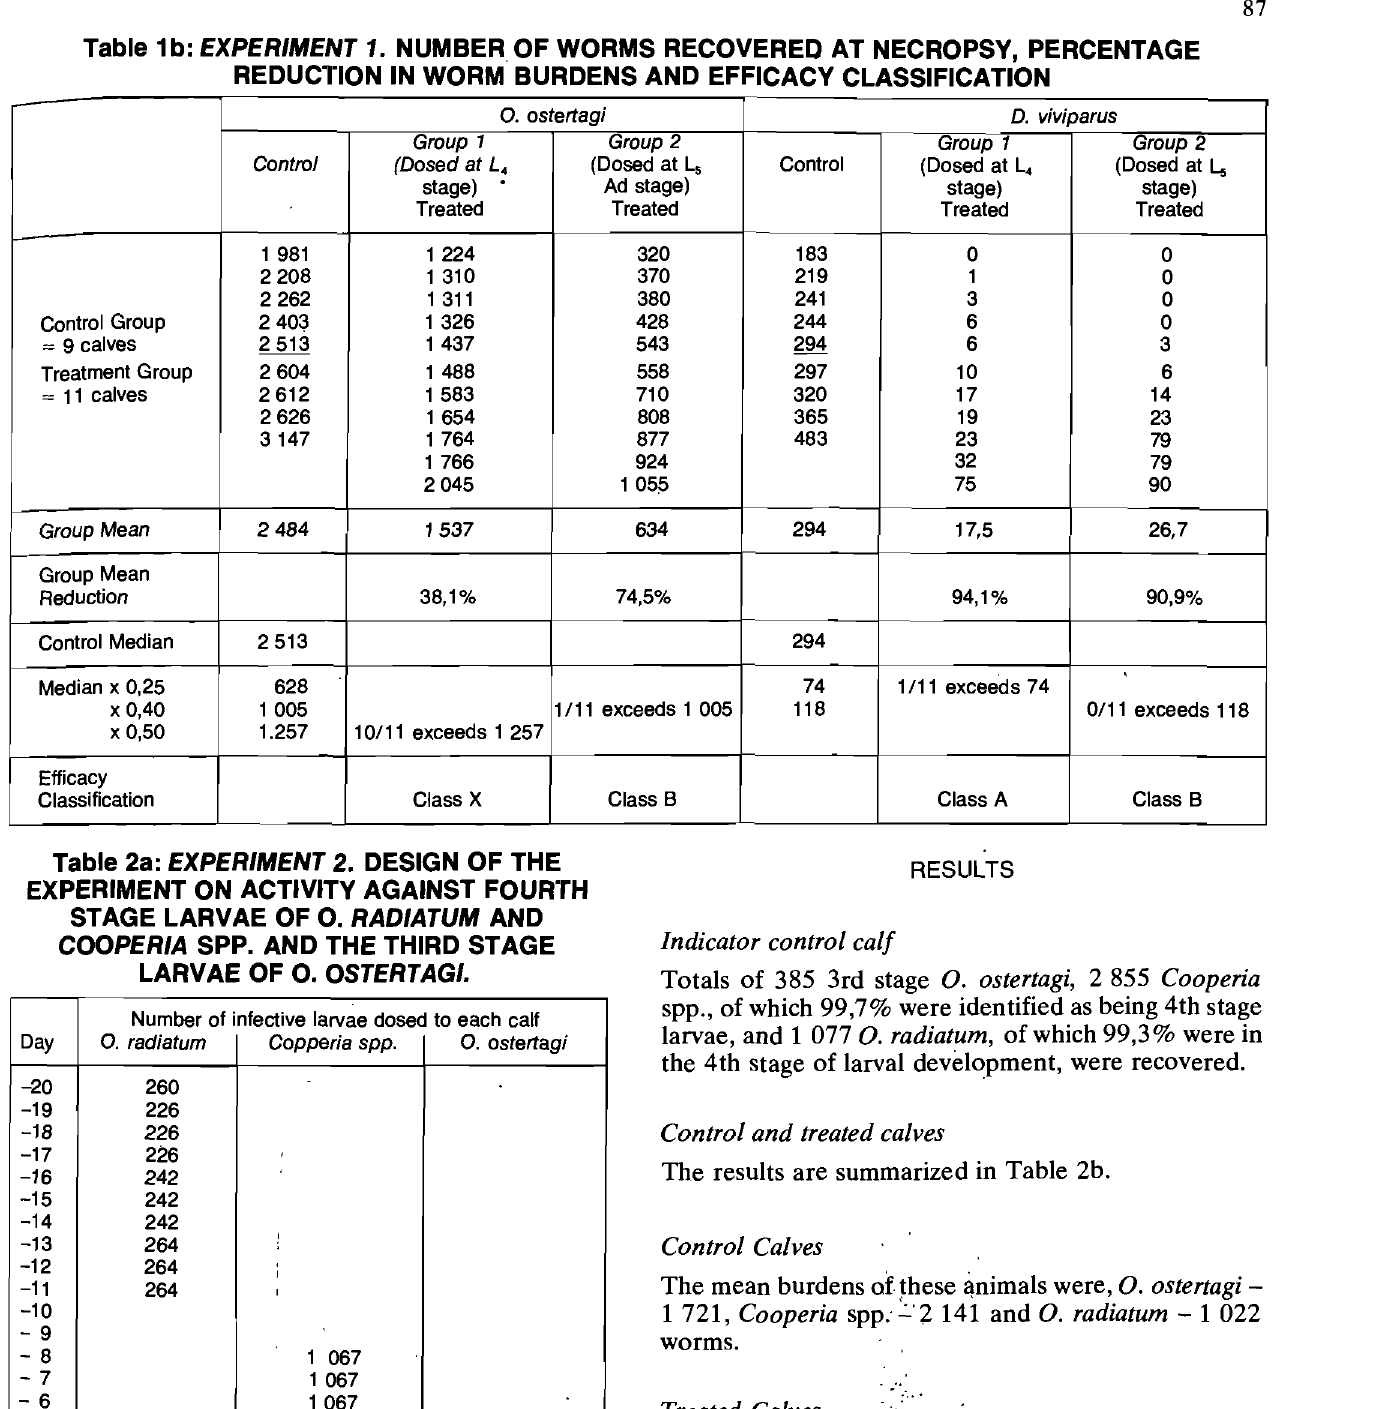
Treatment Group